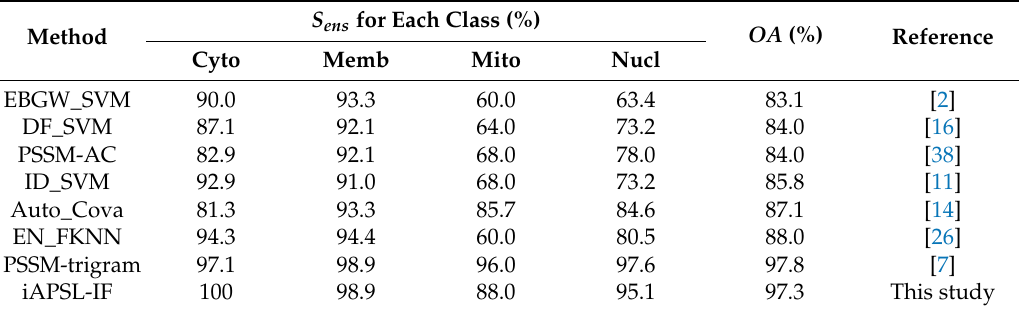
Table 4. Performance comparison of different methods on the ZW225